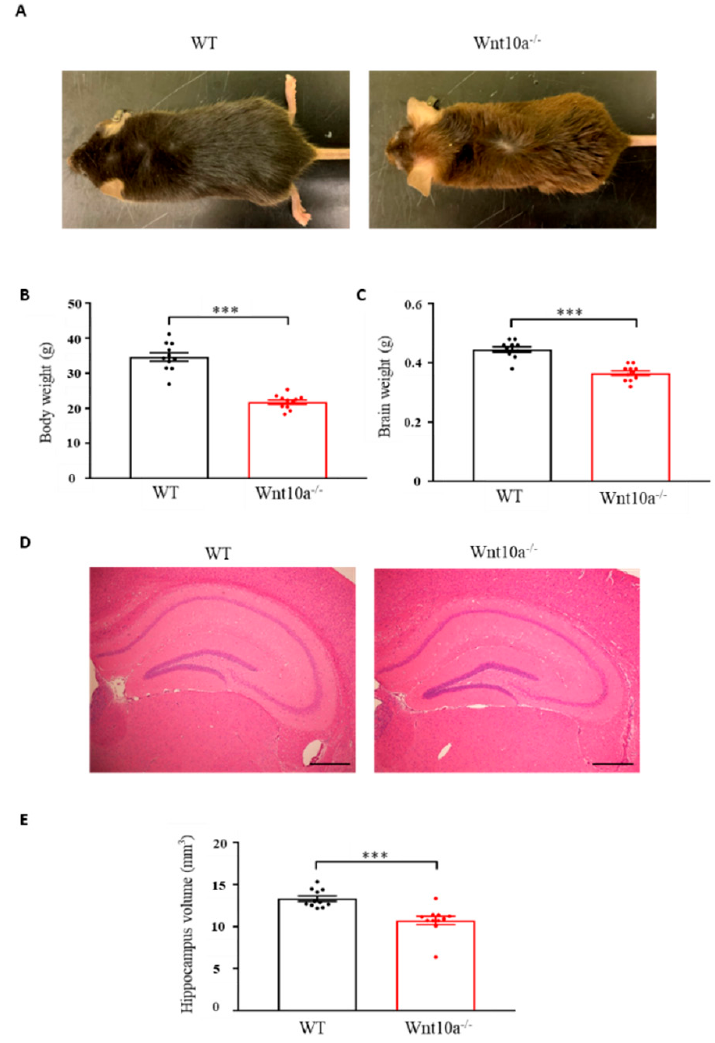
Figure 1. Mouse appearance, body weight, brain weight, and hippocampal volume. Compared with WT mice, Wnt10a -/- mice were smaller in size ( A ). Body weights ( B ), brain weights ( C ), and hippocampal volumes ( D , E ) were significantly lower in Wnt10a -/- mice. Data are expressed as mean ± SEM; n = 11/group; *** p < 0.001; scale bars = 500 μ m.